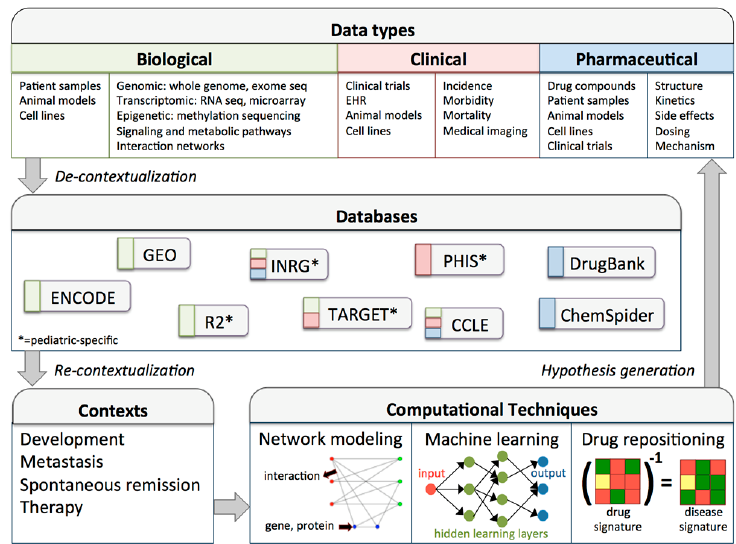
Figure 1. Data-driven research workflow for neuroblastoma or other pediatric cancers. The data types panel enumerates data sources (e.g., animal models) and types (e.g., RNA sequencing) for